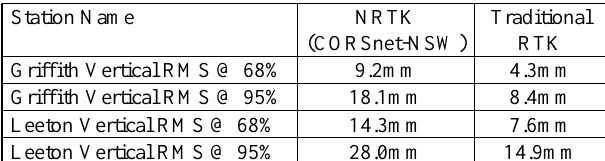
Table 1 : RMSe at both Confidence Intervals